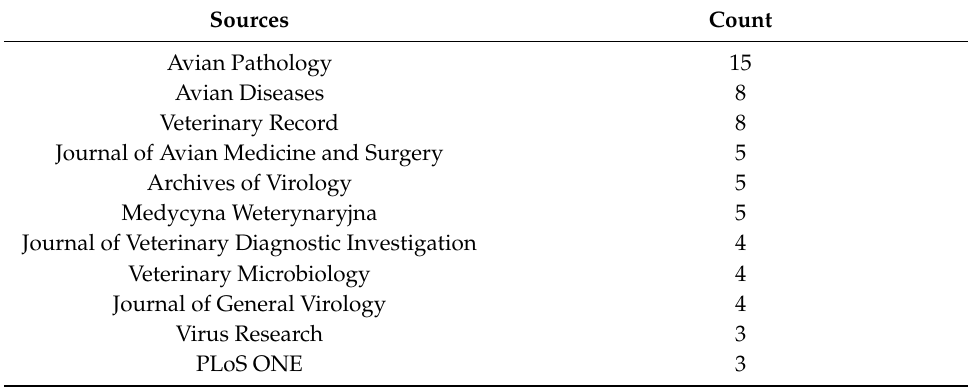
Table 1. Sources with the greatest number of